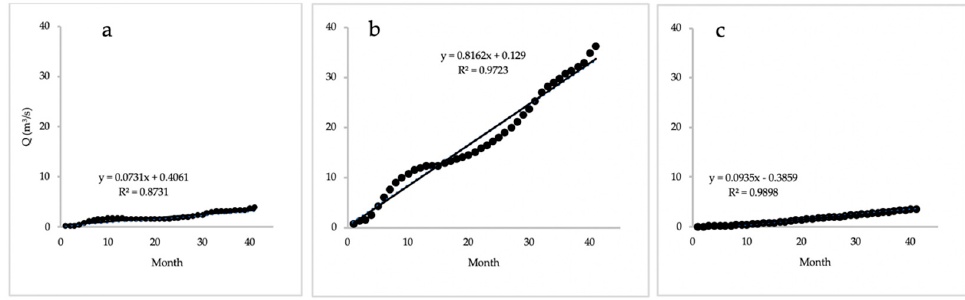
Figure 14. Linear regression analysis. ( a ) Direct rainfall, ( b ) runoff and ( c ) evaporation.